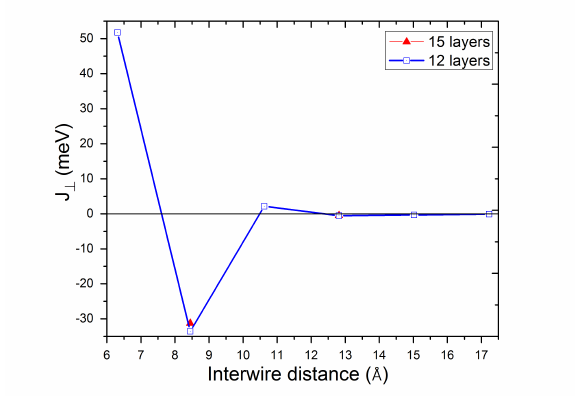
Figure 4. The interwire coupling constants of Fe wires as functions of interwire separation. Blue square and red triangle symbols represent the couplings calculated using 12 and 15 layer slabs, respectively. The blue line connecting the symbols is a guide to the